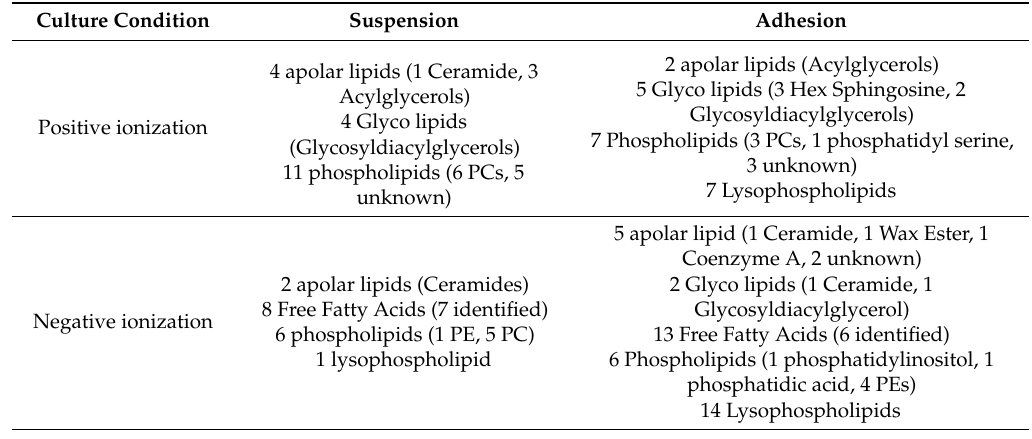
Table 3. Identification of lipid markers related to di ff erent culture